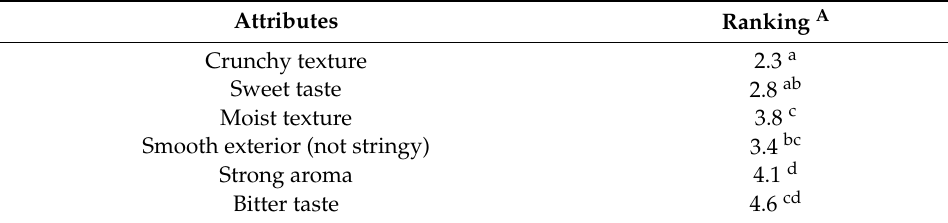
Table 5. Consumers’ ranking for important attributes when consuming celery.